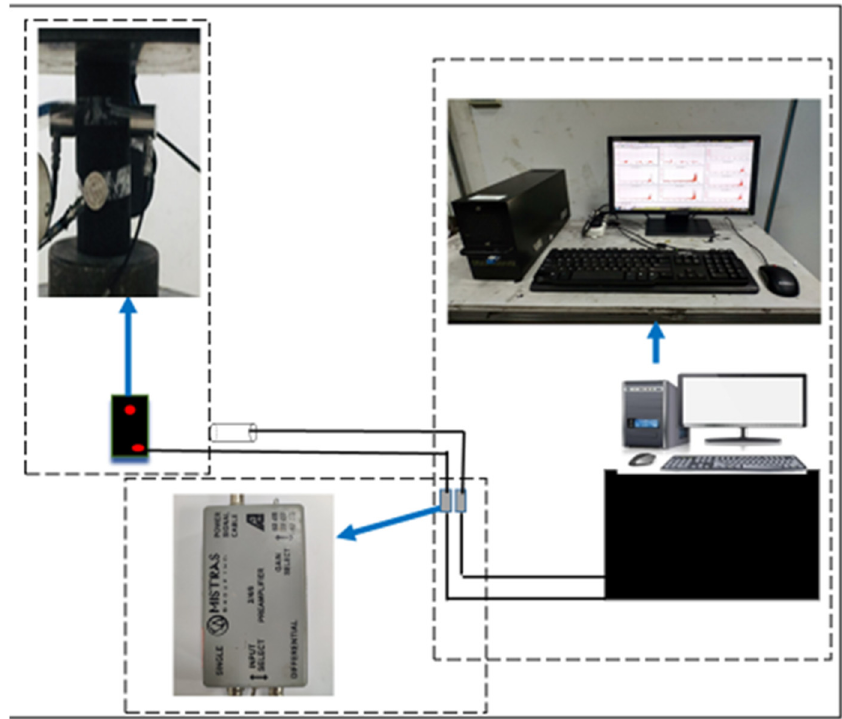
Figure 4. Schematic diagram of AE Data Acquisition System with Photos.